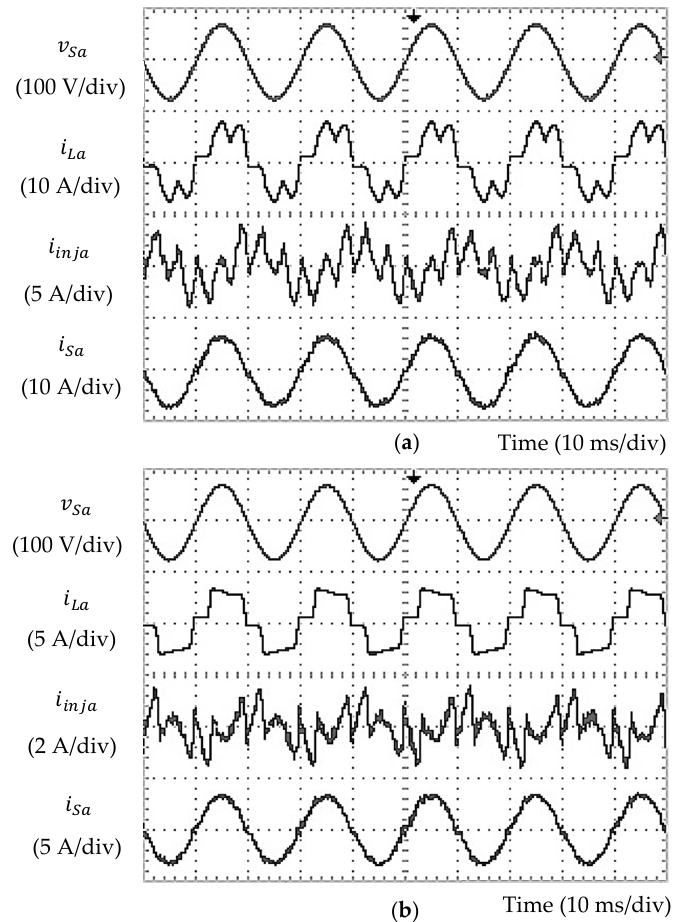
Figure 10. Experimental result showing phase a source voltage v Sa , phase a load current i La , phase a injection current i inja and phase a source current i Sa , demonstrated by SAPF while applying the proposed dual-function pq theory algorithm for: ( a ) capacitive load; and ( b ) inductive load.